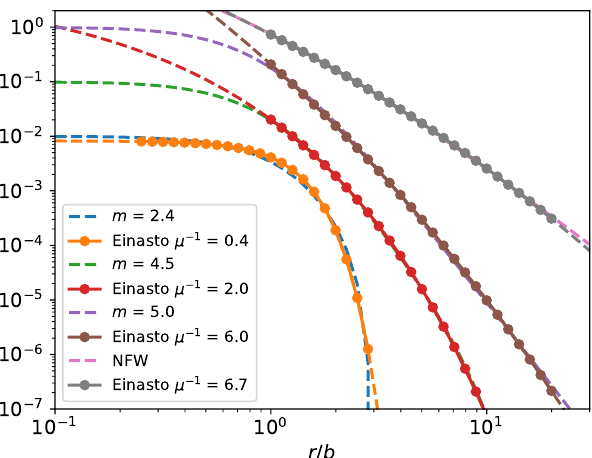
Figure 4. Representative polytropes (dashed lines, as indicated in the inset) fitted with Einasto functions (dashed lines and symbols of the same color). The symbols represent the range of radii included in the fit. Outside the core, the agreement is well within any realistic observational error, an agreement holding for up to a factor ∼ 20 in radius and ∼ 10 5 in surface density. The original polytropic index and the corresponding inverse exponent of the Einasto function ( µ − 1 ) are given in the inset. For display purposes, all profiles have different normalization ( ρ scl ) and are scaled radially to the scale-length of the corresponding polytrope ( b ; Equation (22)). The NFW profile (the pink dashed line) is well fitted by an Einasto profile (grey dots and dashed line), but the shape of this Einasto profile differs from any polytrope of finite size and